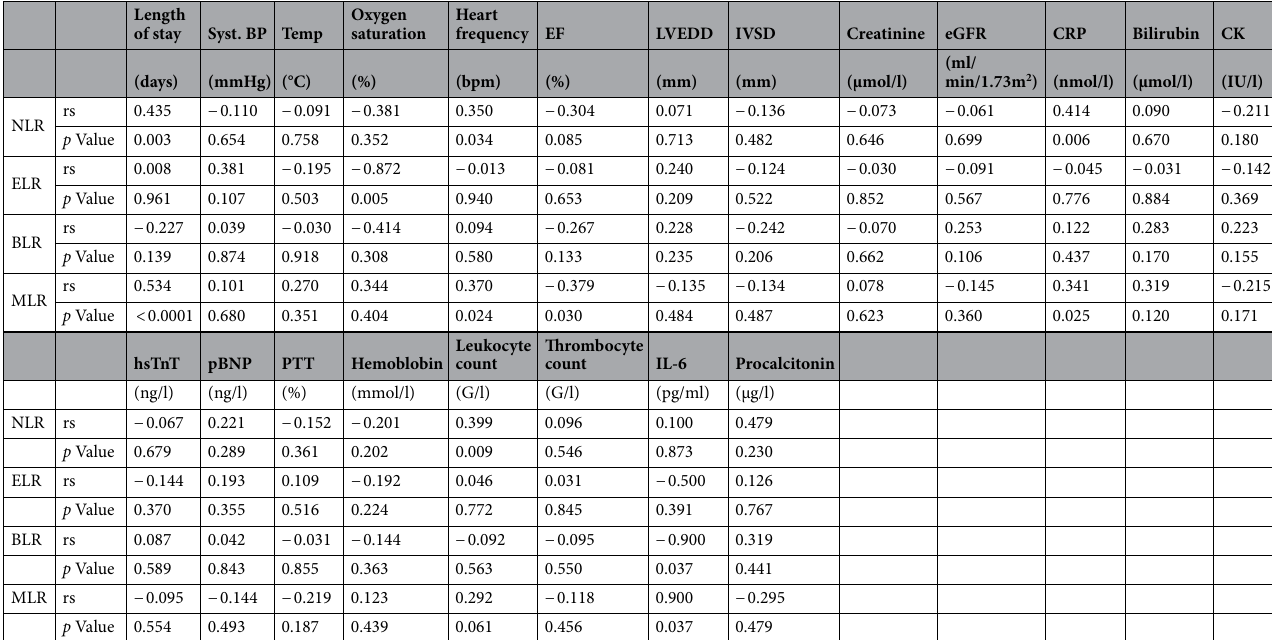
Table 3. Correlation analysis of ratios with clinical and laboratory parameters. Abbreviations: NLR = neutrophil-to-lymphocyte ratio, ELR = eosinophil-to-lymphocyte ratio, BLR =